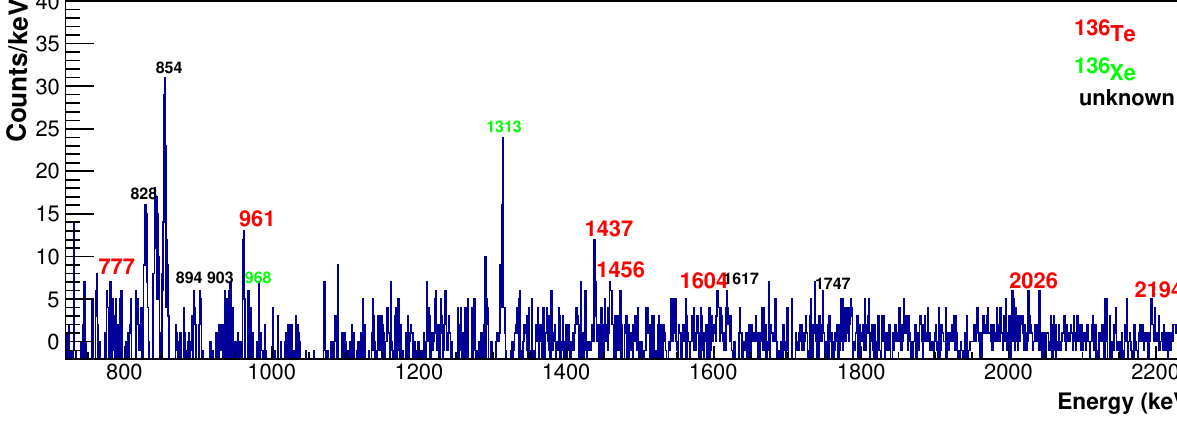
Figure 3. Short-lived energy projection corresponding to the decay of 136 Sb using HpGe detectors and gate on 606 2 + in 136 Te (red) and an additional anti-coincidence gate on the 1313 keV transition 2 + candidates belonging to 136 Te are in